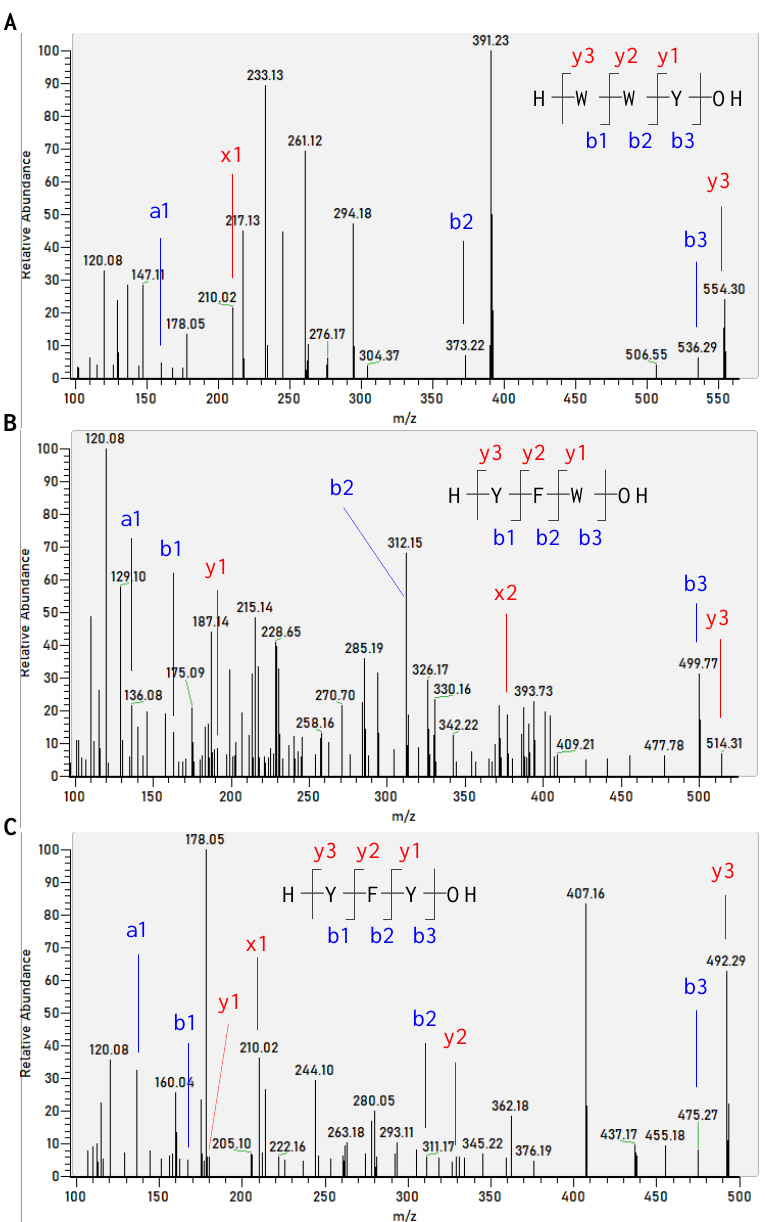
Figure 6. MS/MS spectra of singly charged ions with m/z at 554.30, 515.76, and 492.29 were determined to be the peptides WYW ( A ), YFW ( B ), and YFY ( C ), respectively.